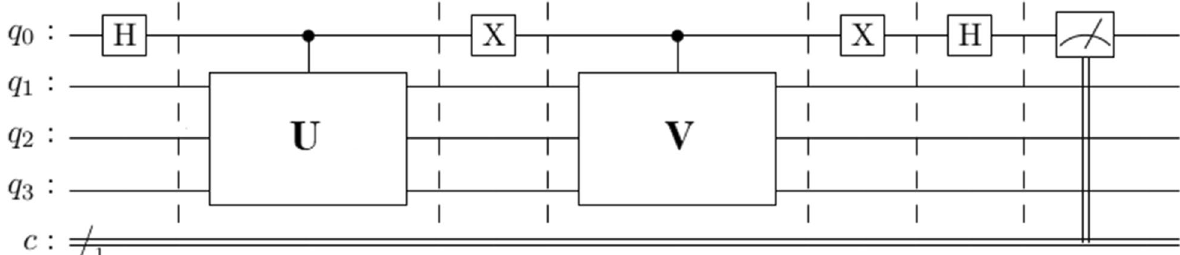
u v . The Hadamard gate puts the � | � u U q 1 q 2 q 3 ). The X gate flips the ancilla qubit. Another � = � v V q 1 q 2 q 3 ) with the excited state � = � (cid:31) (cid:31) (cid:31) (cid:31) (cid:31) (cid:31) u v is (cid:31) (cid:31) � | � =